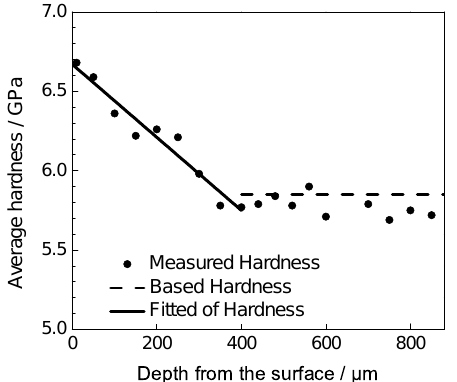
Figure 8. Hardness changes with depth for 0.1 mmA shot-peened IN718